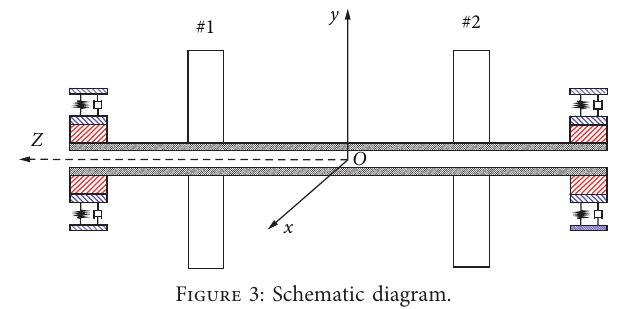
Figure 3: Schematic